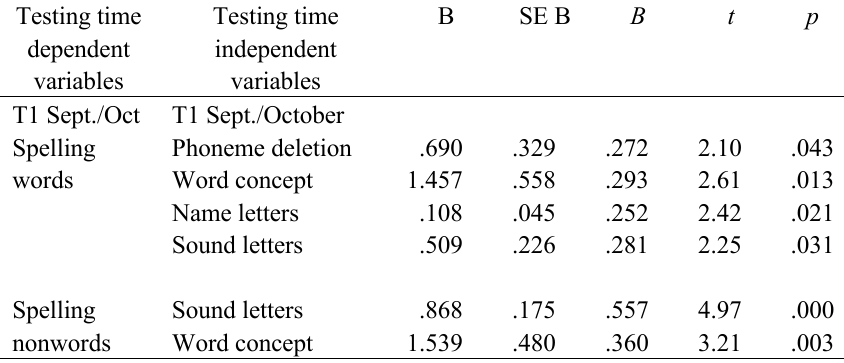
Table 5. Multiple regression analyses predicting spelling at the three testing times with the independent variables from testing time 1 –